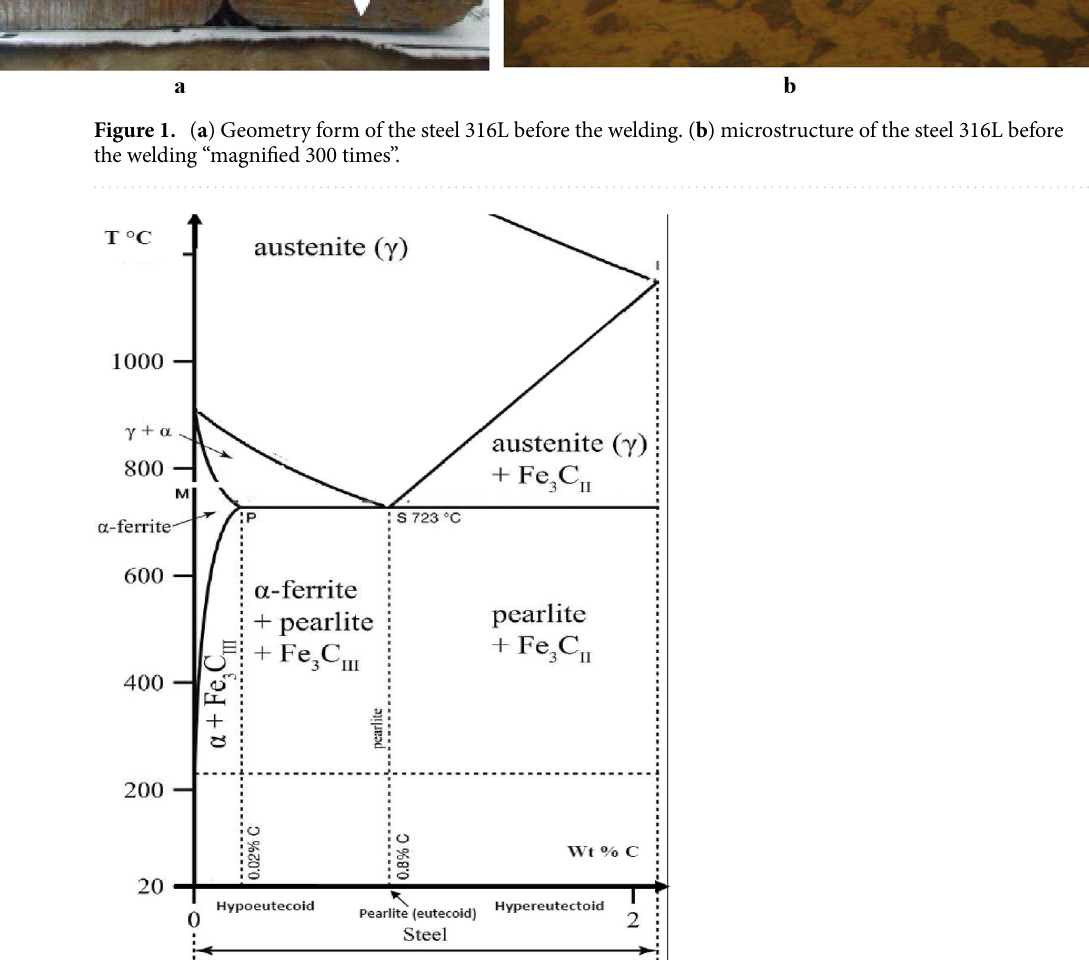
Figure 2. Binary diagram of the steel containing carbon below 2